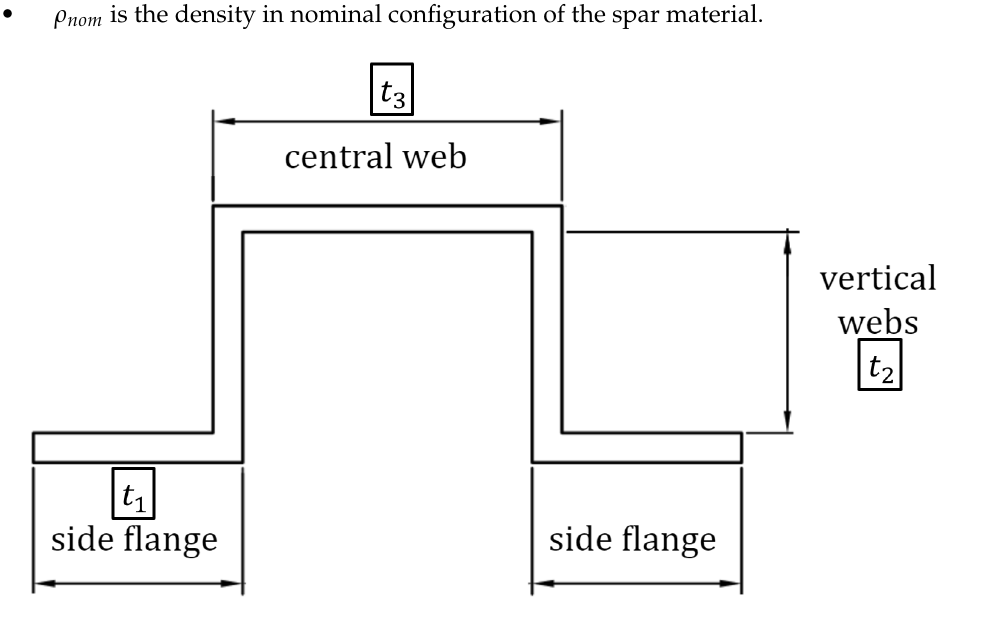
Figure 9. Omega section walls, which have been selected as the main model parameter for the optimization